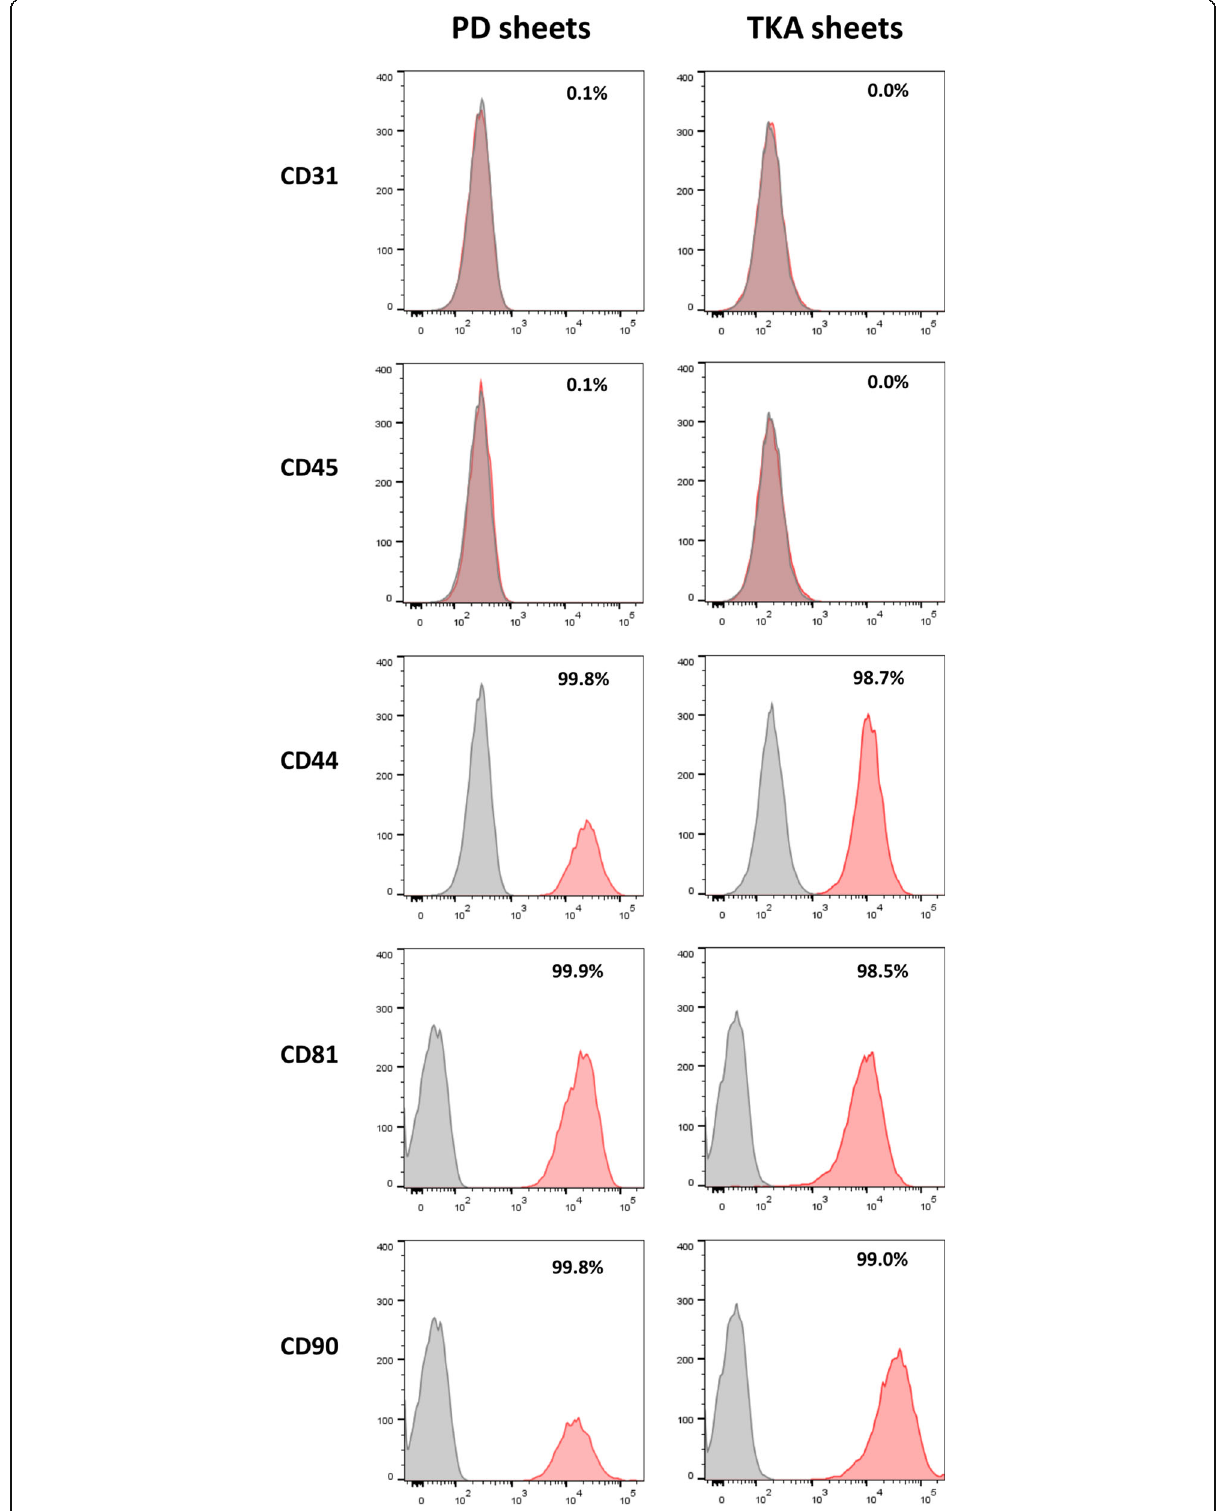
Fig. 4 Flow cytometric analysis of surface markers. Results are shown for the flow cytometric analysis of hematopoietic cell markers CD31 and CD45 and mesenchymal stem cell markers CD44, CD81, and CD90. The target markers are indicated in red, and IgG isotype controls are indicated in gray. Both PD sheets and TKA sheets were negative for CD31 and CD45 and positive for CD44, CD81, and